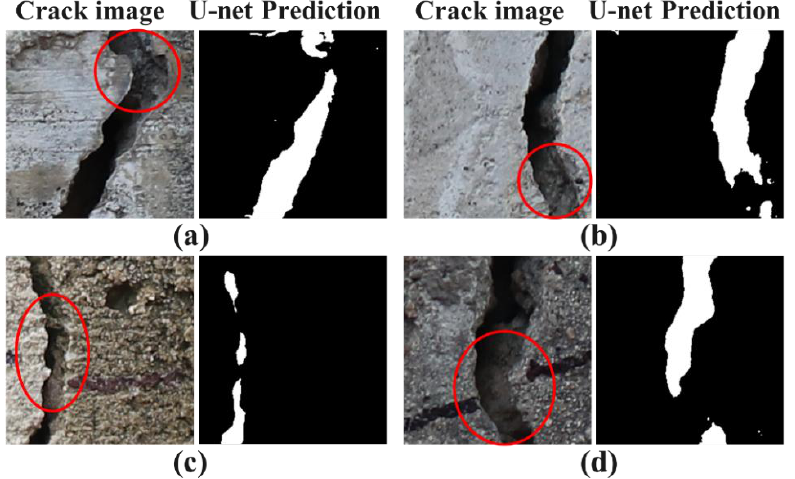
Figure 27. The interference of the protrusion deep in the crack on the accuracy of dam crack segmentation. ( a ) segmentation discontinuity, red circle is the protrusion position; ( b ) segmentation error, red circle is the different protrusion style; ( c ) missing part of crack segmentation, red circle is the continuous protrusion; ( d ) protrusion similar to concrete surface, red circle is the protrusion position.